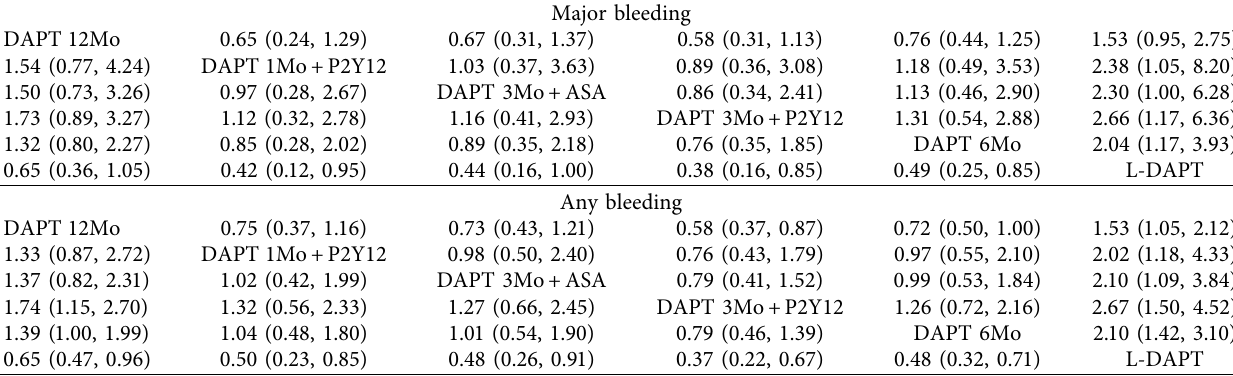
Table 2: Pooled estimates of hemorrhagic endpoints of sensitivity analysis.